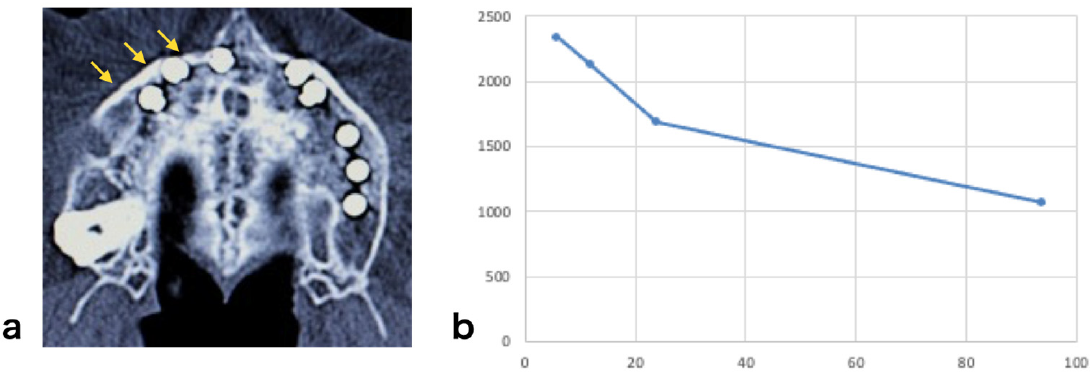
Figure 9. CT image and regenerated bone volume: ( a ) representative CT image of the regenerated alveolar bone with alveolar ridge augmentation and ( b ) time course of the regenerated bone volume.